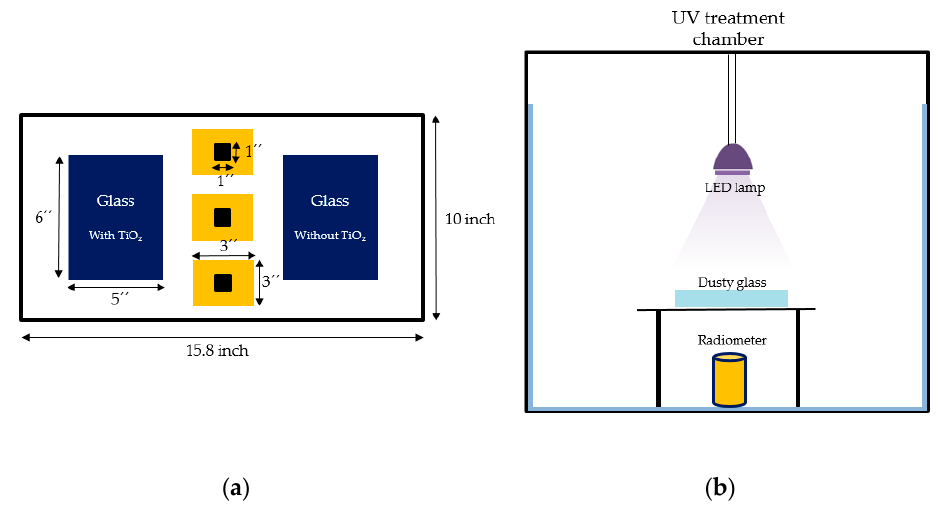
Figure 2. Investigation of the effect of accumulated poultry dust on photocatalysis. ( a ) Dust collection box; ( b ) Schematic of the method used for measuring the light absorption by the accumulated dust on the glass (i.e., the bottom layer of the reactor in Figure 1) with and without TiO 2 .